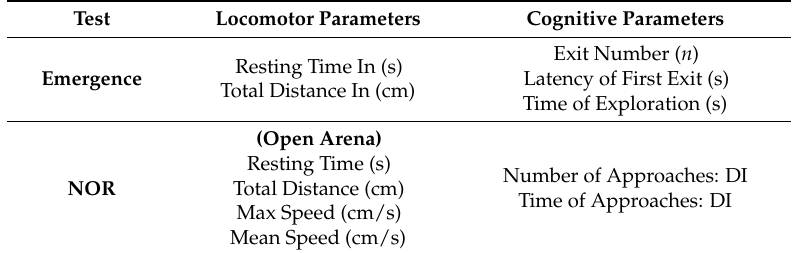
Table 1. Selected parameters to measure locomotor and cognitive performances in each task. DI = discrimination index between novel/repositioned and familiar object. NOR = novel object